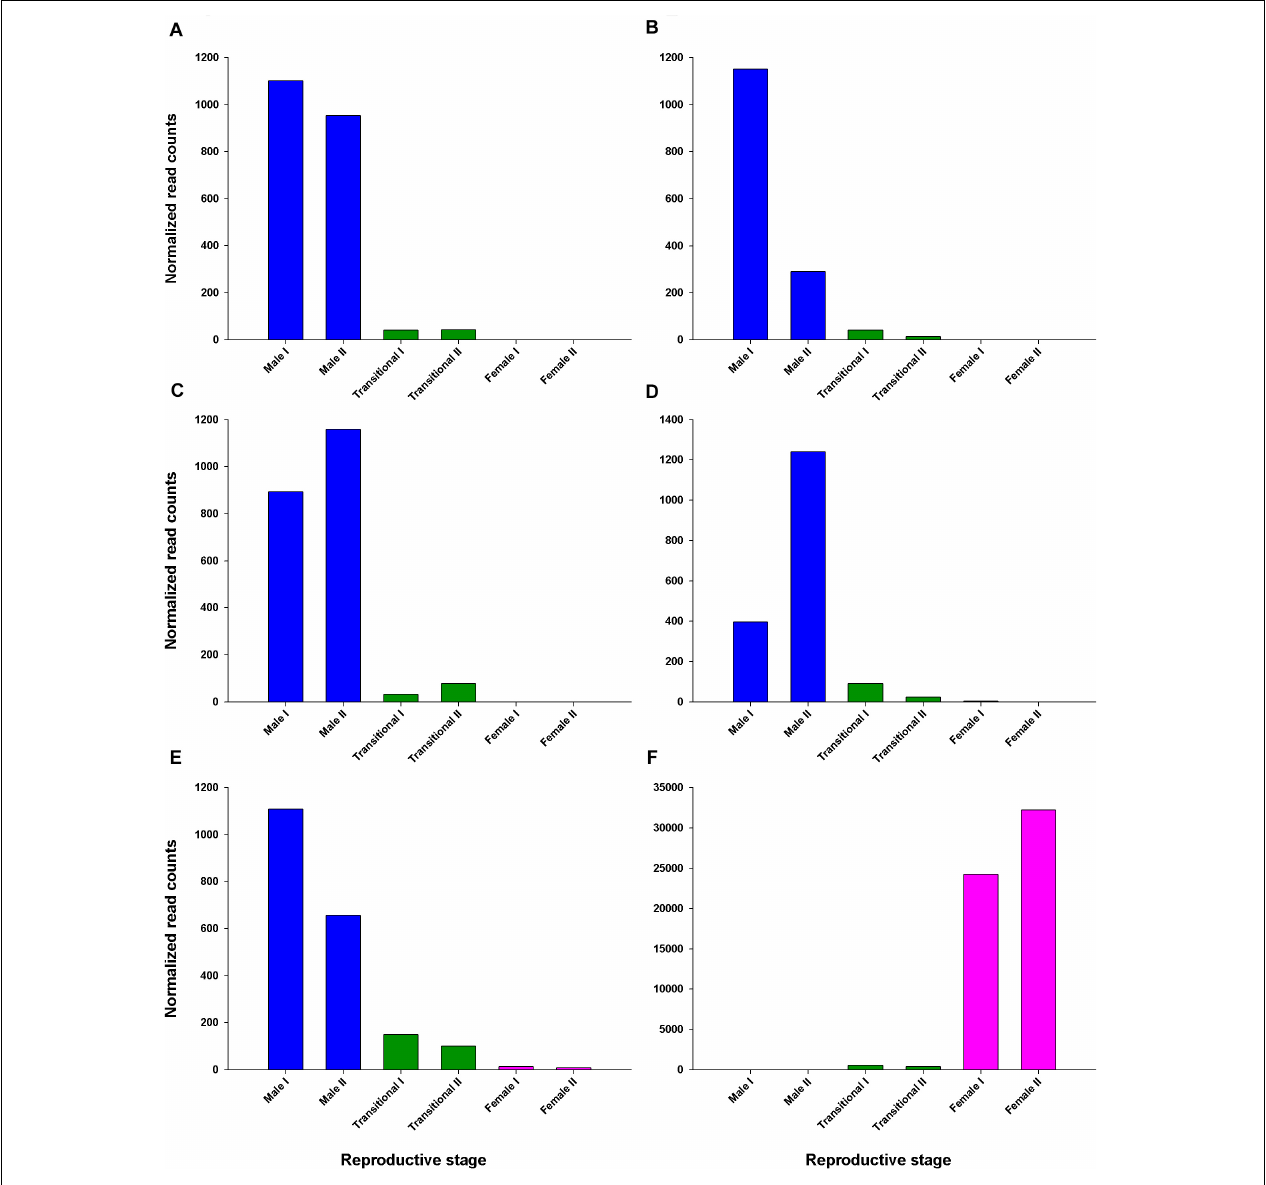
FIGURE 6 | Read counts of AG differentially expressed genes correlated with Pnp-IAG transcriptional pattern throughout the P. platyceros life-history. Normalized read counts of each of the two replicates per reproductive stage that were sequenced to assemble the P. platyceros RNA library described in this study. (A–E) Genes with decreasing transcriptional pattern (i.e., Pnp-IAG-switch 1-5 ). (F) A gene with increasing transcriptional pattern (i.e., Pnp-IAG-switch 6 ). Genes considered significant according to the following parameters: FDR adjusted P -value < 0.05 and absolute linear fold change > 1.3. A detailed list of the above genes is given